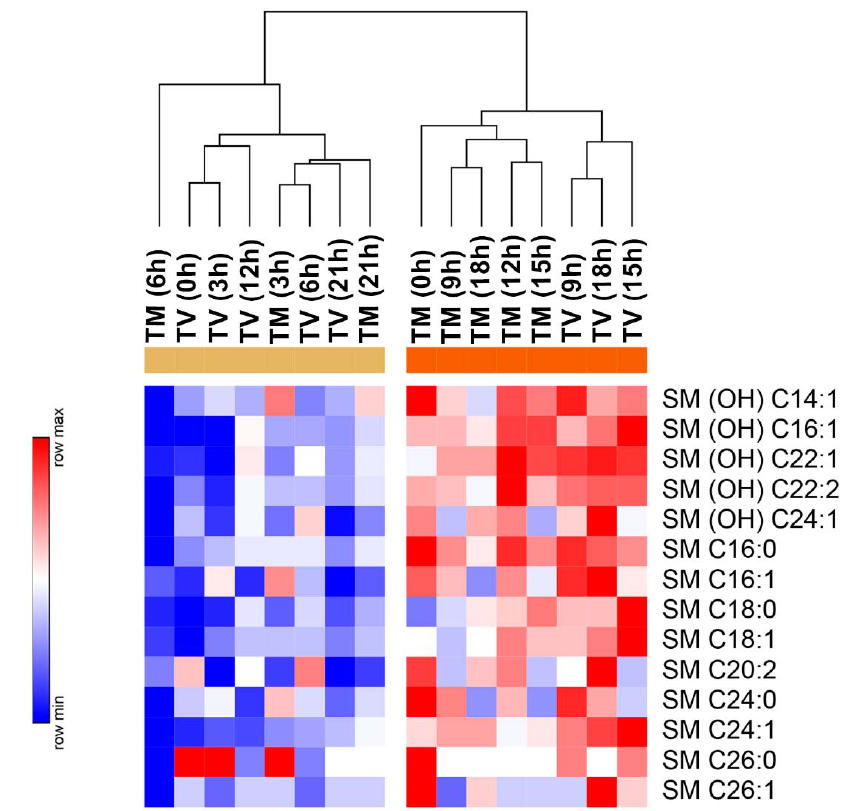
Figure 6. Profile of sphingolipids evaluated daily in BC-bearing mice after melatonin treatment. Heat maps illustrating the normalized mean levels of 14 different sphingomyelins, visualized as minimum “blue” and maximum “red” values. We used one factor of clusterization (melatonin treat- ment vs. vehicle throughout the day (06:00, 09:00, 12:00, and 15:00) and throughout the night (18:00, 21:00, 00:00, and 03:00) by columns; Euclidean distance analysis).